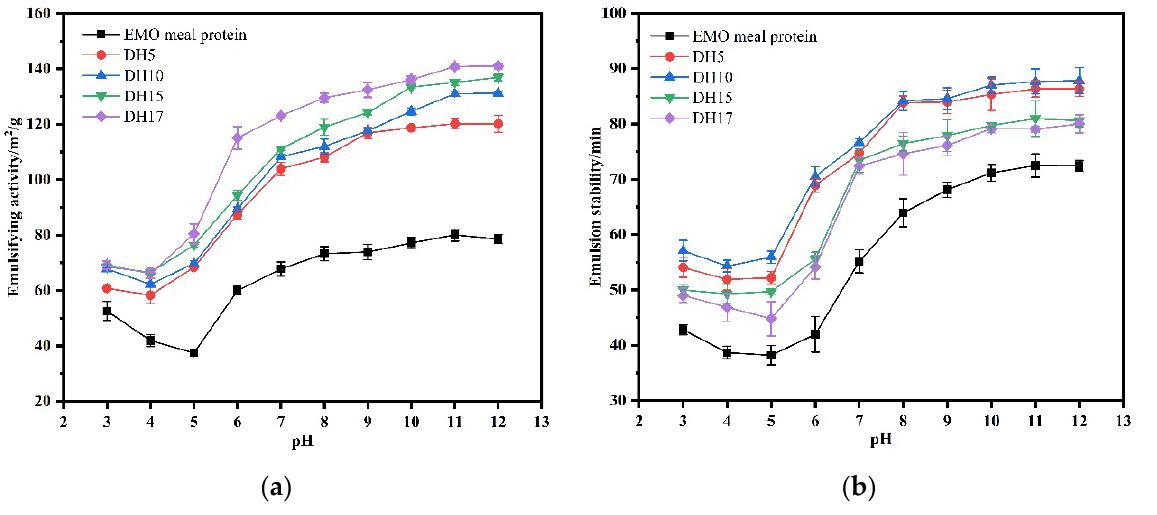
Figure 10. Effect of pH on emulsifying capacity ( a ) and emulsion stability ( b ) of the EMO meal pro- tein and hydrolysates with different DH.